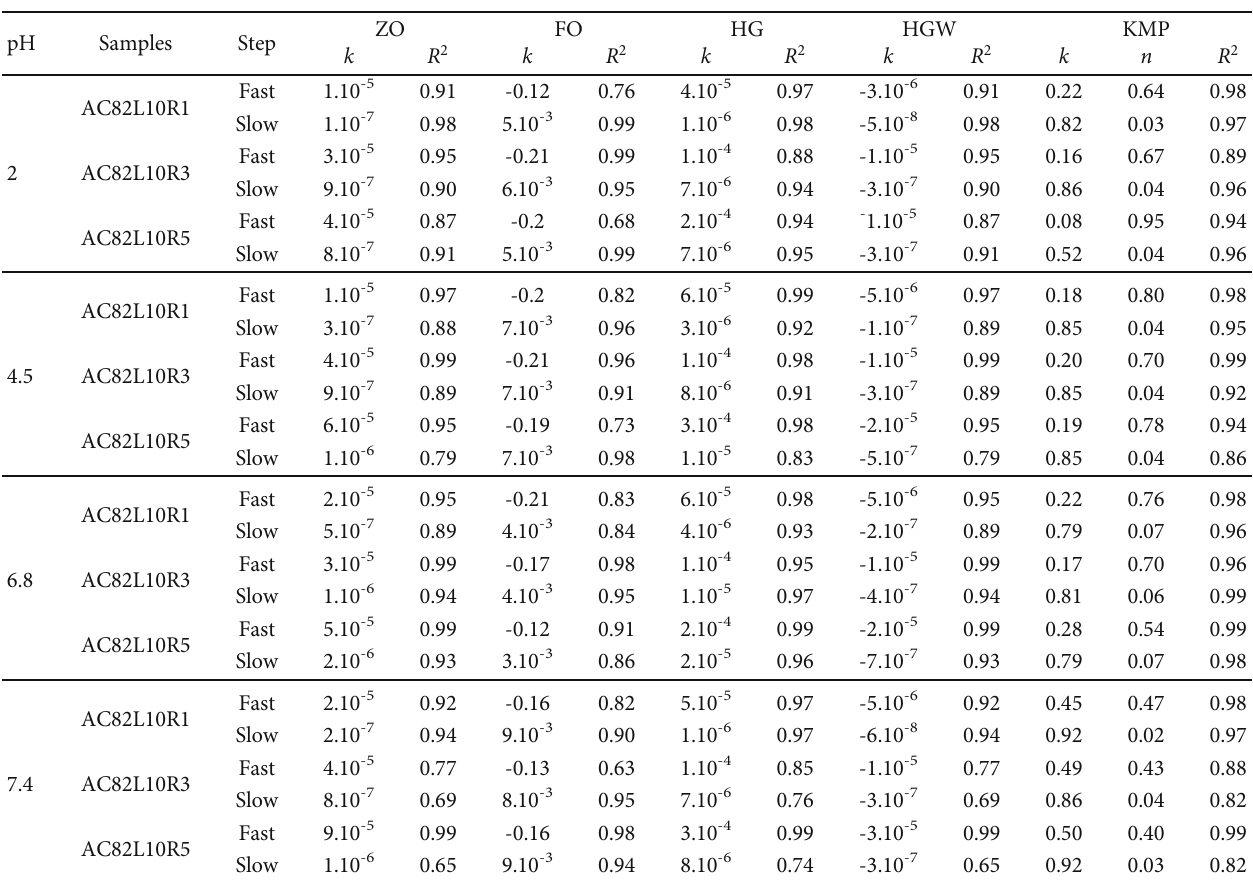
Table 8: Regression coe ffi cient ( R 2 ) and release constant ( k ) obtained from kinetic equations re fl ecting Rb1 release from the ACLR fi lms in bu ff er solutions. pH